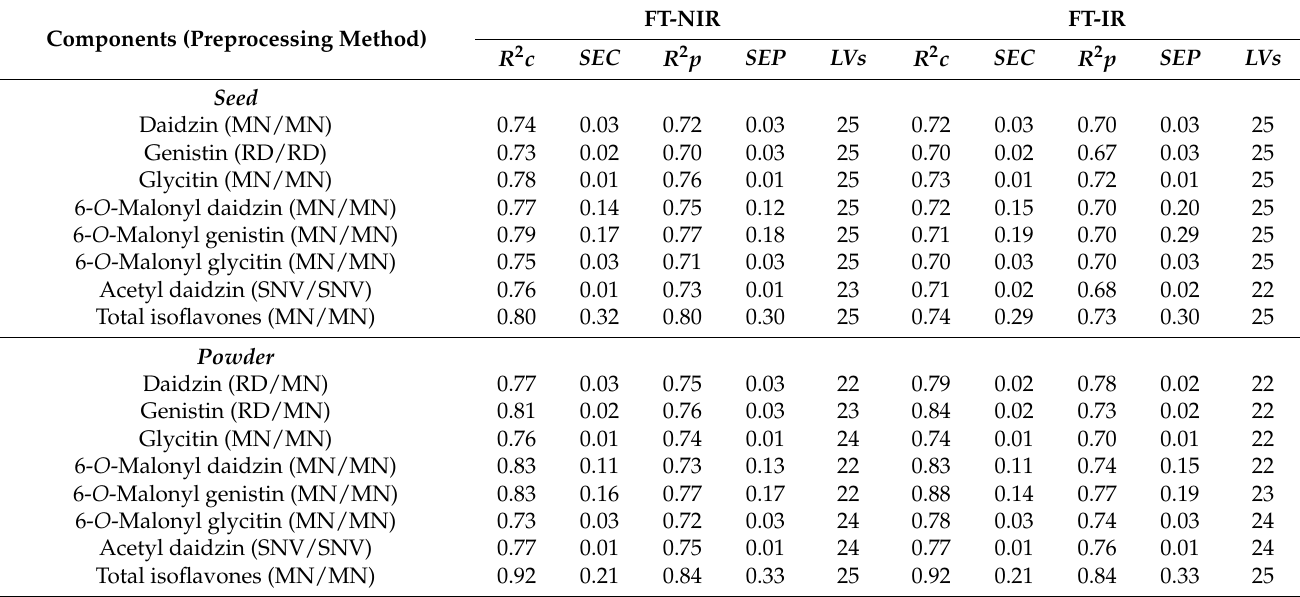
Table 2. The PLSR statistical model for predicting total isoflavones and individual forms of isoflavones in soybeans using FT-NIR and FT-IR